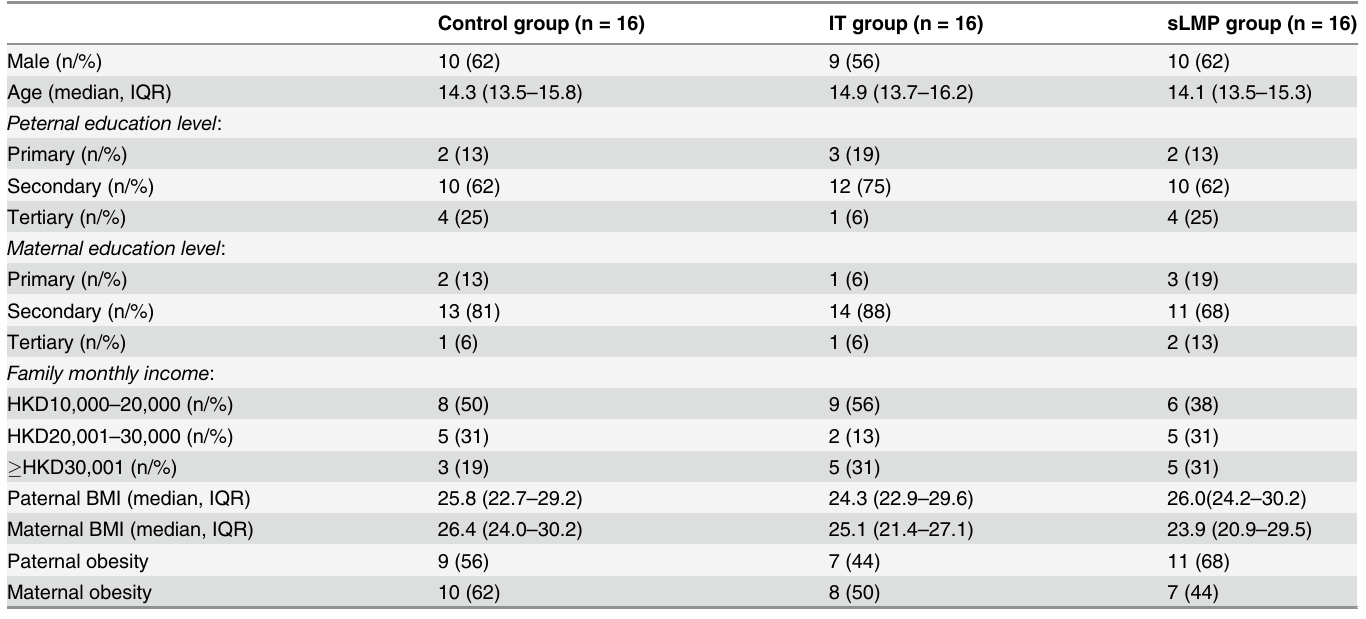
Table 2. Demographic characteristics of the control group, internet (IT) intervention group and simplified Lifestyle Modification Programme (sLMP) group. Control group (n =